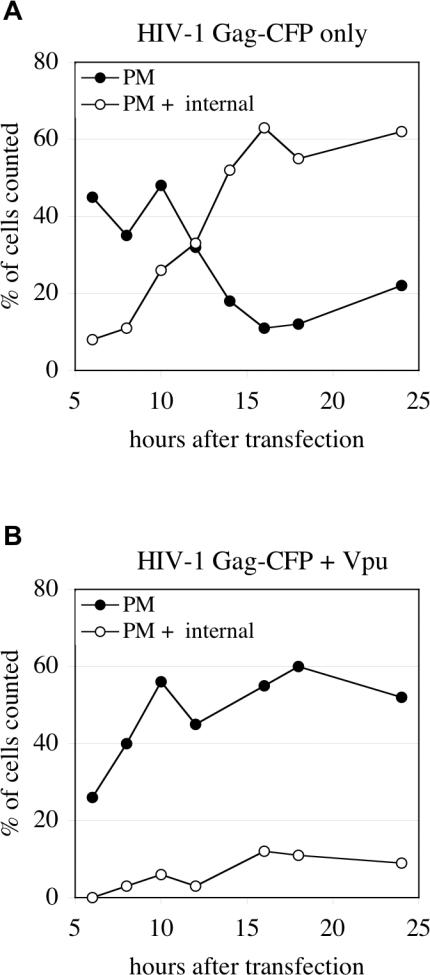
HIV-1 Gag-CFP Accumulation at the PM Precedes Accumulation at Intracellular Sites in HeLa Cells in the Absence of Vpu Expression(A and B) HeLa cells were transfected with HIV-1 Gag-CFP and either an irrelevant plasmid control (A) or a Vpu-expression plasmid (B). The cells were washed 5 h post-transfection and then fixed at 2-h intervals thereafter. The number of cells in ten fields that exhibited HIV-1 Gag-CFP accumulations at the PM only or at the PM and intracellular sites, or which expressed only diffuse Gag-CFP, were enumerated as in Figure 1C and plotted as the percentage of the total. Cells containing only diffuse Gag-CFP have been omitted from the charts for simplicity.